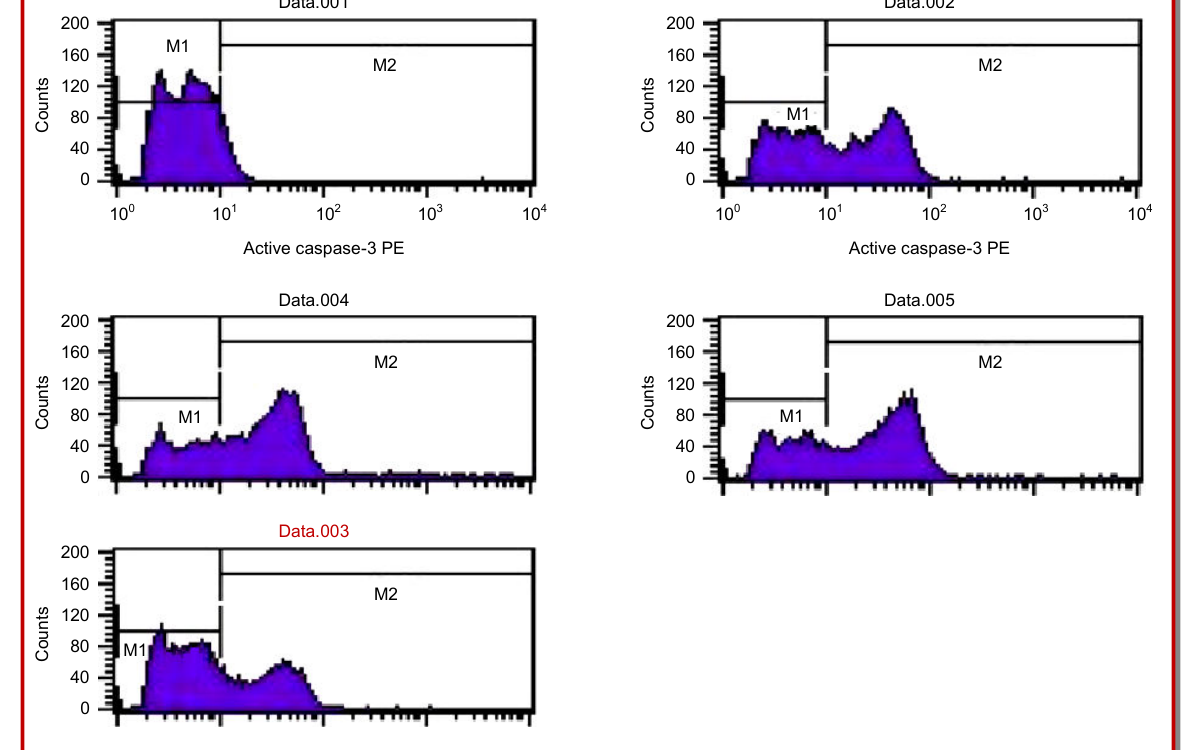
Figure 7: The induction of apoptosis by Tv-7, Tv-58 and Tv-62 in CHO cells. Flow cytometric analysis of populations of untreated control cells (Data.001) and cells induced for 2 hours with Tv-7 (Data.004), Tv-58 (Data.003), Tv-62 (Data.002) and staurosporine (Data.005) using anti-active caspase-3-PE antibody. M1 represents cell population, which were negative for the presence of active caspase-3, whereas M2 represents cell populations, which were positive for active caspase-3-PE